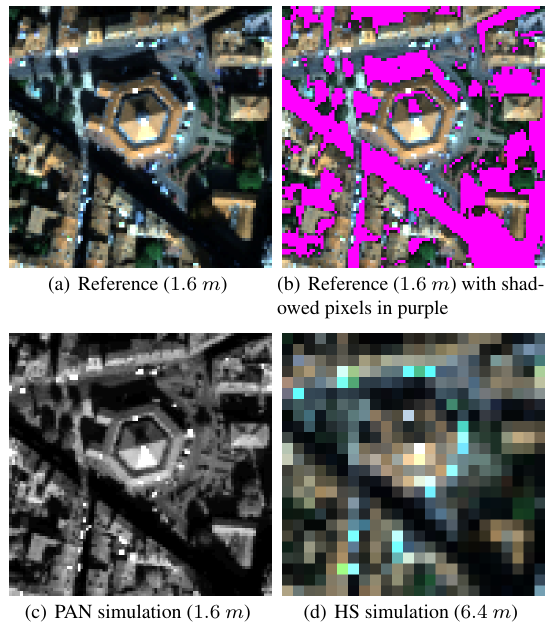
Figure 3. "Halle" dataset (spatial resolutions in brackets)